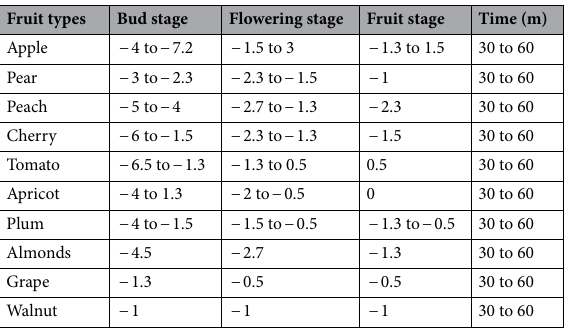
Table 2. Critical temperature (°C) of fruit trees in different stages of growth.